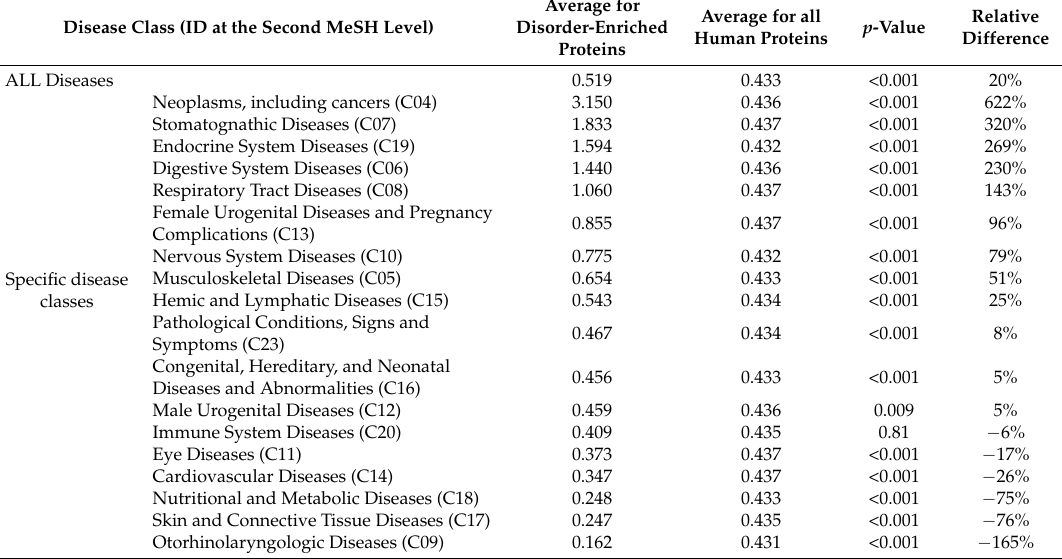
Disease Class (ID at the Second MeSH